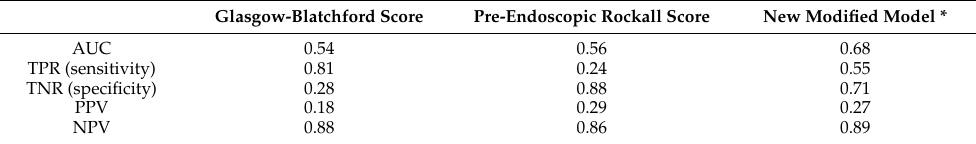
Table 2. Prediction model performance for endoscopic intervention.